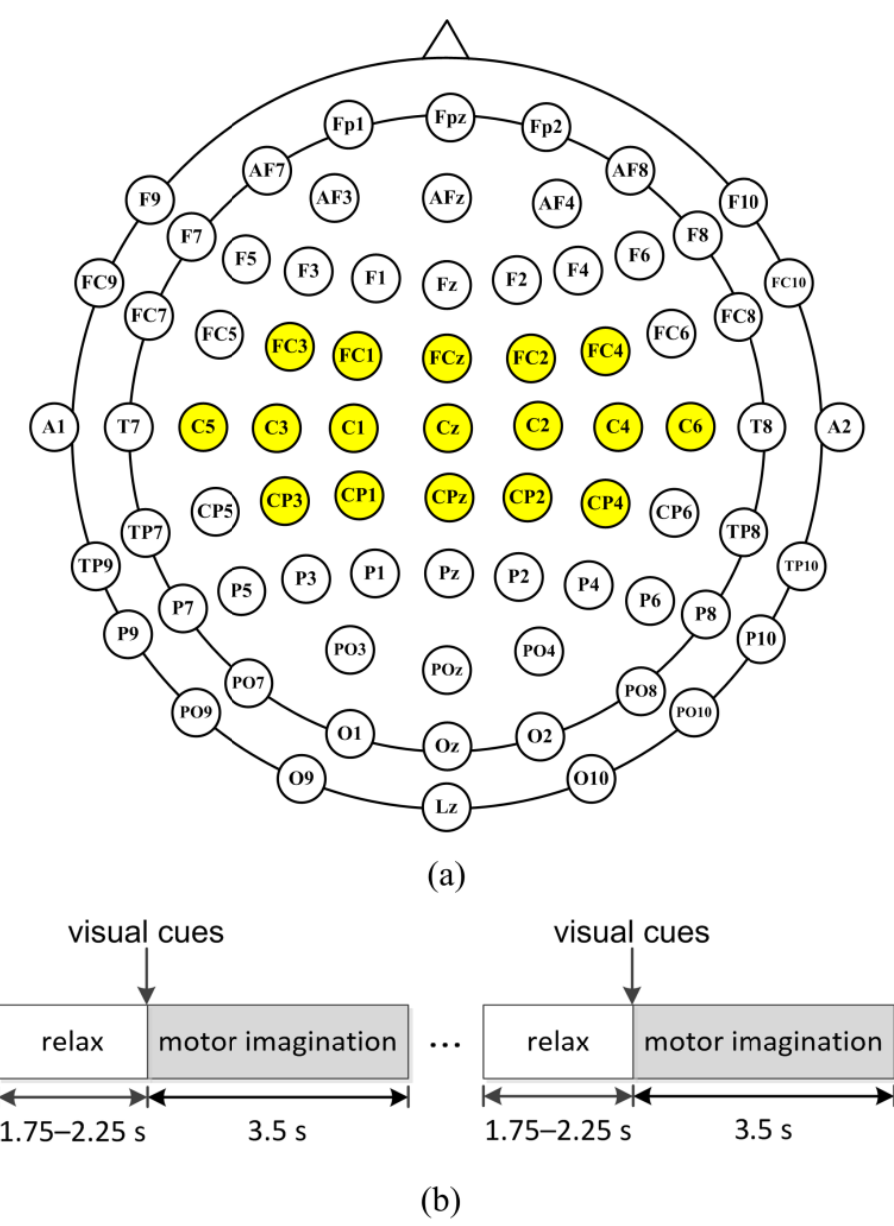
Figure 2. ( a ) Electrodes used in our study (yellow circles) according to the extended international 10 – 20 system. ( b ) The scheme of the experiment. A single trial of the experiment was divided into two periods. In the first period, the subject relaxed for 1.75 – 2.25 s; and then the visual cues were indicated for 3.5 s when the subject performed the motor